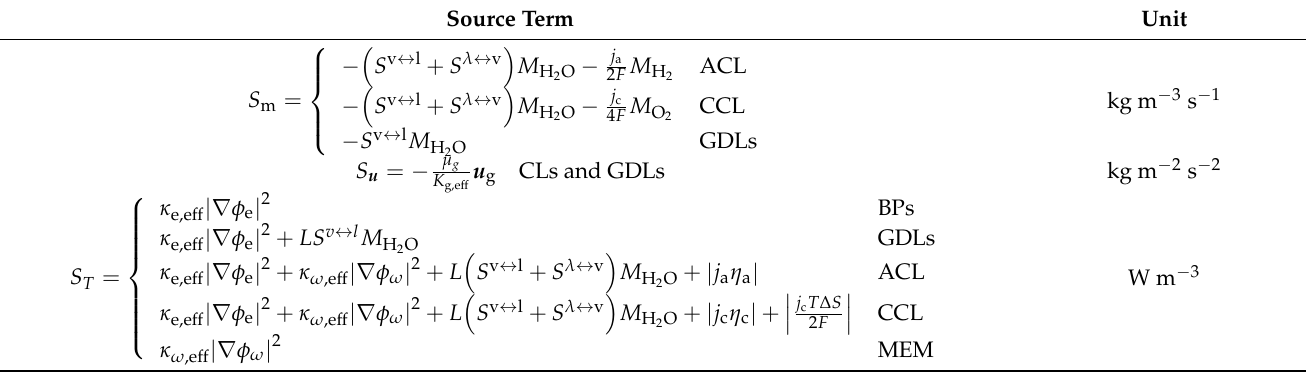
Table 3. Source terms of conservation equations for the